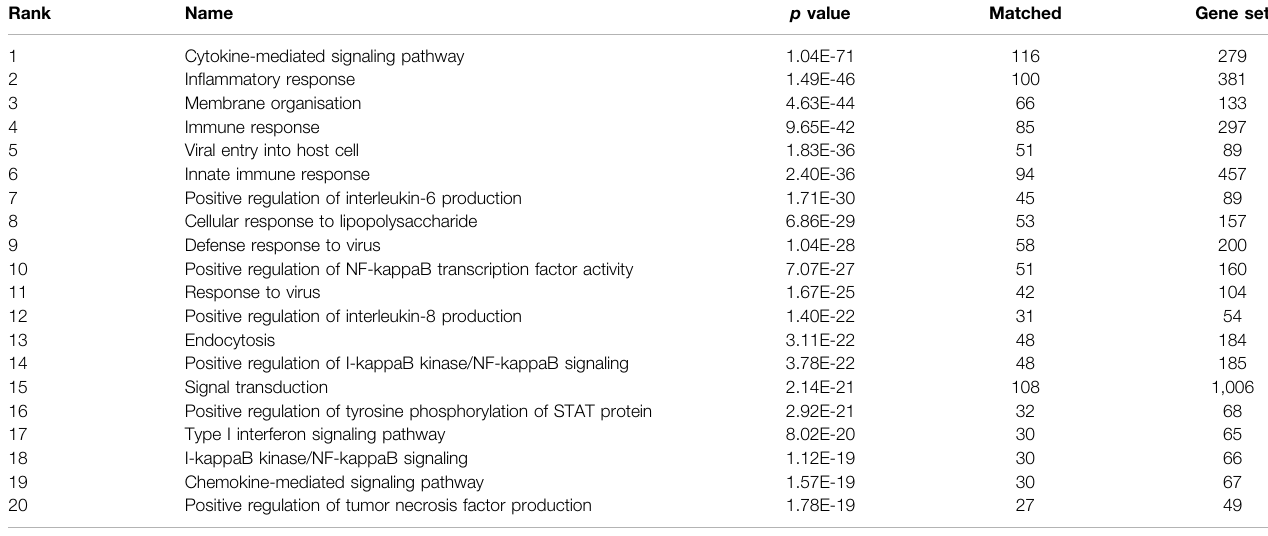
TABLE 3 | Top 20 enriched biological processes (Gene Ontology) in the fi nal network.